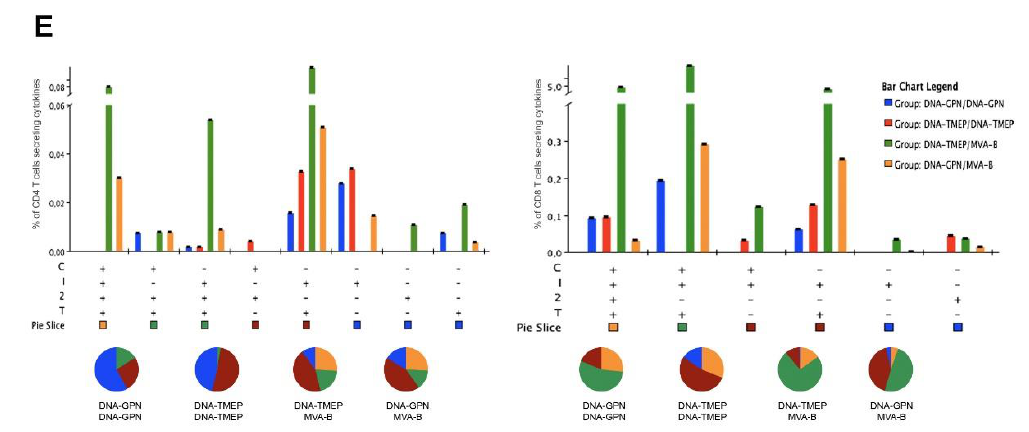
Figure 2. Polyfunctional Gag–Pol–Nef (GPN)-specific CD4 and CD8 T cell immune responses elicited in spleen after prime/boost immunization of mice with TMEP-B construct and modified vaccinia virus Ankara (MVA)-B recombinant virus. ( A ) Immunization schedule. Groups of 6–8-week-old female mice ( n = 4) received 50 µ g of pcDNA- IIIB GPN, pcDNA-TMEP-B, or pcDNA- ϕ by bilateral intramuscular route (i.m.); three weeks later, they received a bilateral i.m. inoculation of 50 µ g of DNA (pcDNA- IIIB GPN, pcDNA-TMEP-B, or pcDNA- ϕ ) or 1 × 10 7 pfu of MVA-wild type (WT) or MVA-B viruses. At 10 days after the last immunization, mice were sacrificed and spleens were processed for intracellular cytokine staining (ICS) assay to analyze Gag–Pol–Nef-specific T cell immune responses. Two independent experiments have been performed for the different groups. Magnitude of the Gag- and GPN-specific CD4 ( B ) or CD8 ( C ) T cell immune responses were measured at 10 days post-boost by ICS assay after stimulation of splenocytes from immunized animals with the different HIV-1 clade B peptide pools. The total value in each group indicates the sum of the percentages of CD4 + or CD8 + T cells secreting CD107a and/or IFN- γ and/or IL-2 and/or TNF- α against Gag/GPN peptide pools. Data are background subtracted. *** p < 0.001. ( D ) Flow cytometry profiles of vaccine-induced CD8 T cell responses against Gag-1 or GPN-3 peptide pools in the groups immunized with the heterologous combinations DNA/MVA. ( E ) Functional profile of the Gag/GPN-specific CD4 (left panel) or CD8 (right panel) T cell responses in the different immunization groups. Positive combinations of the responses are represented on the x axis, whereas the percentages of the functionally distinct cell populations within the total CD4 or CD8 T cells are shown on the y axis. Responses are grouped and colour-coded based on the number of functions. Non-specific responses obtained in the control groups were subtracted in all populations. C: CD107a; I: IFN- γ ; 2: IL-2; T: TNF- α